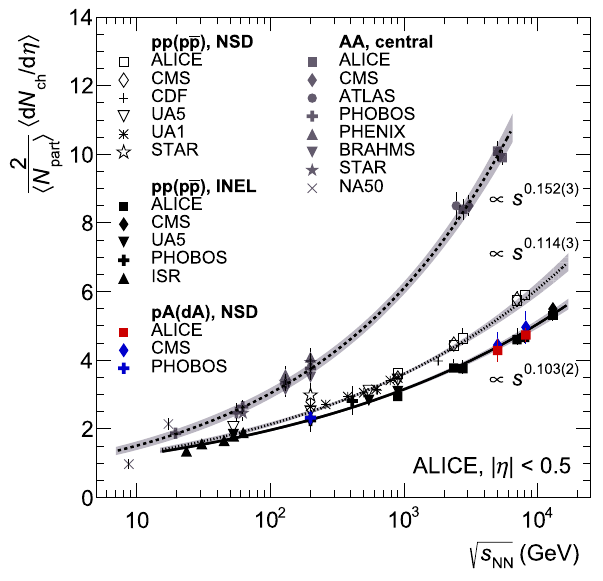
(cid:3) d N / d η (cid:4) for pA [34,37,38], pp and pp [35, Fig. 4 Values of 2 (cid:3) ch N part (cid:4) 39–47] along with those from central AA collisions [48–58] as a func- √ | η | < 0 . 5. All values of (cid:3) N s tion of NN are shown, for normalisation of data are the results of Glauber model calculations. The s -dependencies of the pp (pp) inelastic (INEL) and p–Pb collisions data are proportional to s 0 . 103 (solid line), while pp (pp) NSD are pro- NN portional to s 0 . 114 (dashed middle line). AA are proportional to s 0 . 152 NN (dashed upper line). The bands show the uncertainties on the extracted power-law dependencies for inelastic pp collisions [35,46,47]. The dependence of / d η (cid:4) on the centre-of-mass energy can be fitted with (cid:3) d N ch